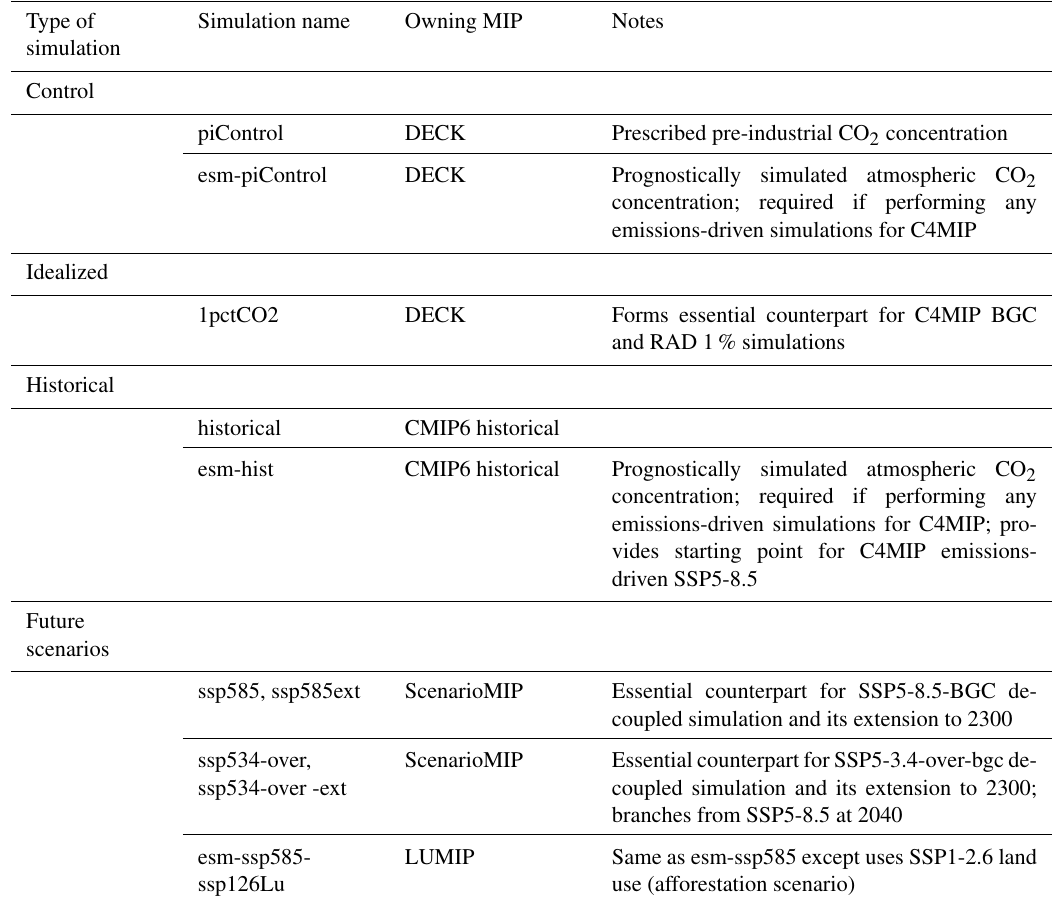
Table 2. Summary of key simulations from CMIP6 DECK, historical or other MIPs on which C4MIP analysis will rely. The emissions-driven control and historical runs in particular are entry card requirements for